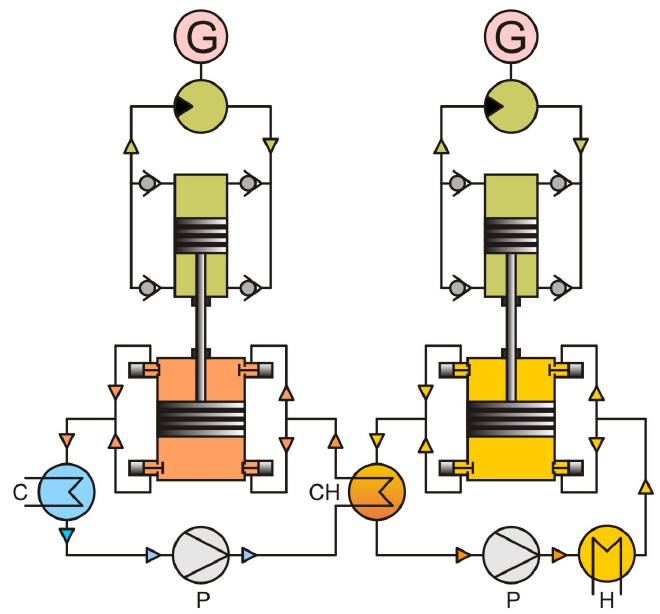
Figure 8. Heat-to-electricity converter based on Worthington-type engine working in cascade configuration. Pump (P), heater (H), condenser/cooler (CH), cooler (C) and electric generator (G).